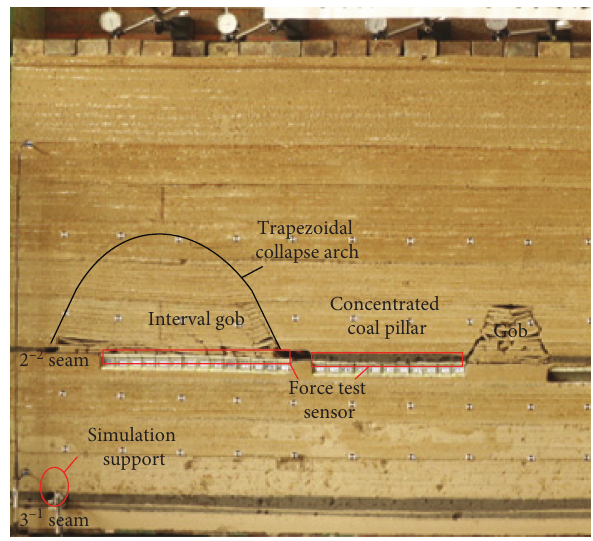
Figure 3: The characteristics of overburden collapse before working face entering coal